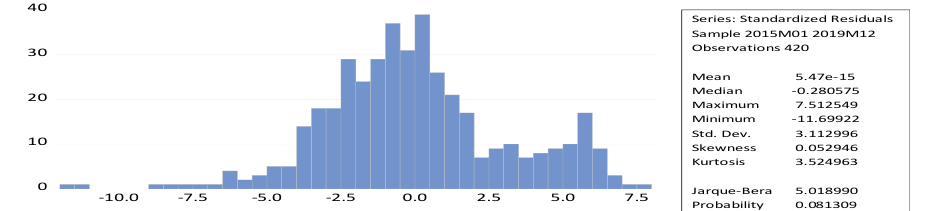
Figure 1: Normality